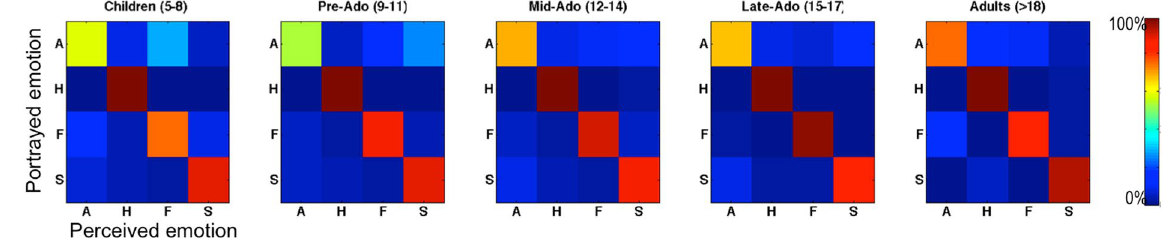
Figure 4. Confusion matrices for the five age groups. Each cell indicates number of times each emotion was chosen by participants (columns) as a function of the actual portrayed emotion (rows). A: Anger; H: Happiness; F: Fear; S: